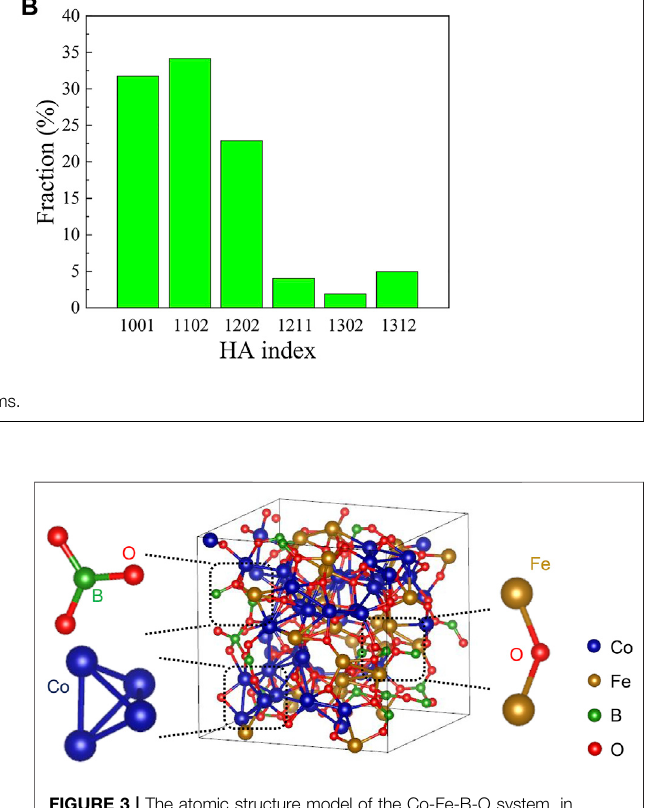
FIGURE 3 | The atomic structure model of the Co-Fe-B-O system, in which the enlarged parts are the BO 3 structural unit, the tetrahedral structural unit consisting of four Co atoms and oxygen-mediated Fe-O-Fe